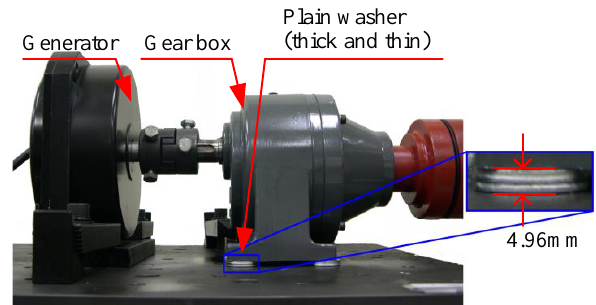
Figure 8. Operation of healthy condition.